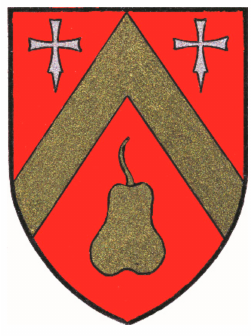
Figure 6. The coat of arms of Bishop Francisco Clemente Sapera (1410–1415).